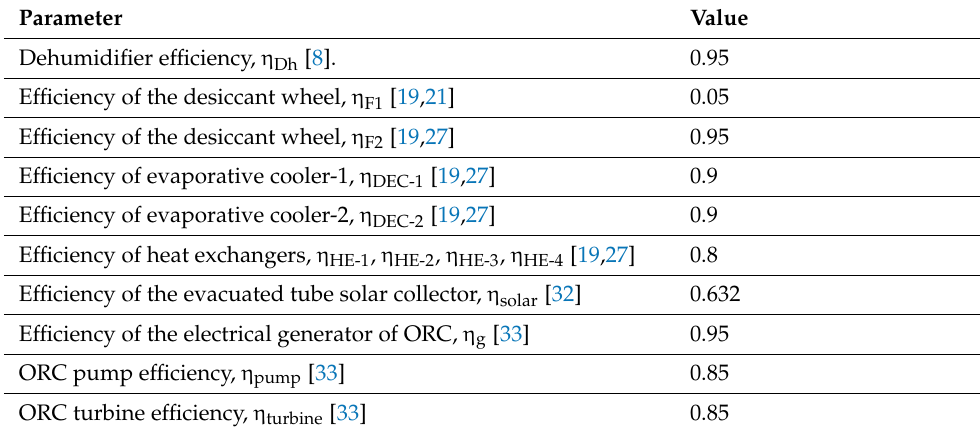
Table 2. Efficiencies of the system’s components. Parameter Dehumidifier efficiency, η Dh